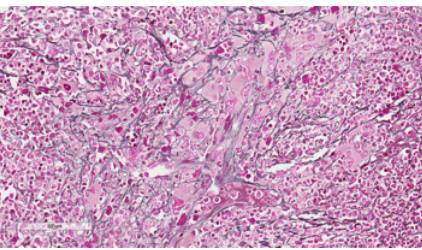
Figure 4: Reticulin stain of bone marrow showing 2+